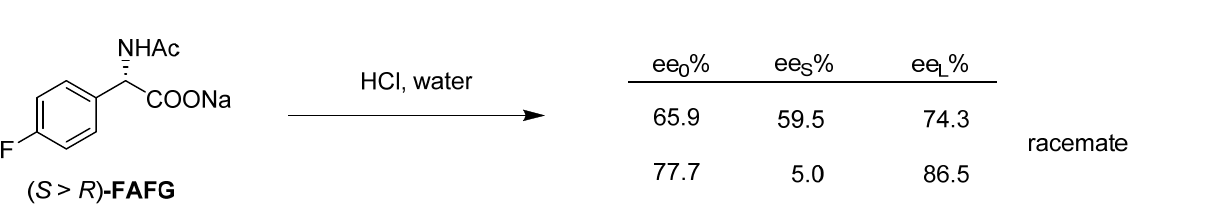
Figure 25. The release of the Na-salt of R -fluoro- N -acetyl-phenylglycine. From the aqueous solution of the hydrochloric acid salt of the Tetramisole ( TET ) enantiomeric mixture, upon addition of sodium hydroxide equivalent to the fraction of the enantiomeric raceme, the largest part is separated (filtered out), cooled, and the enantiomeric excess is obtained by further alkalizing the mother liquor (Figure 26).